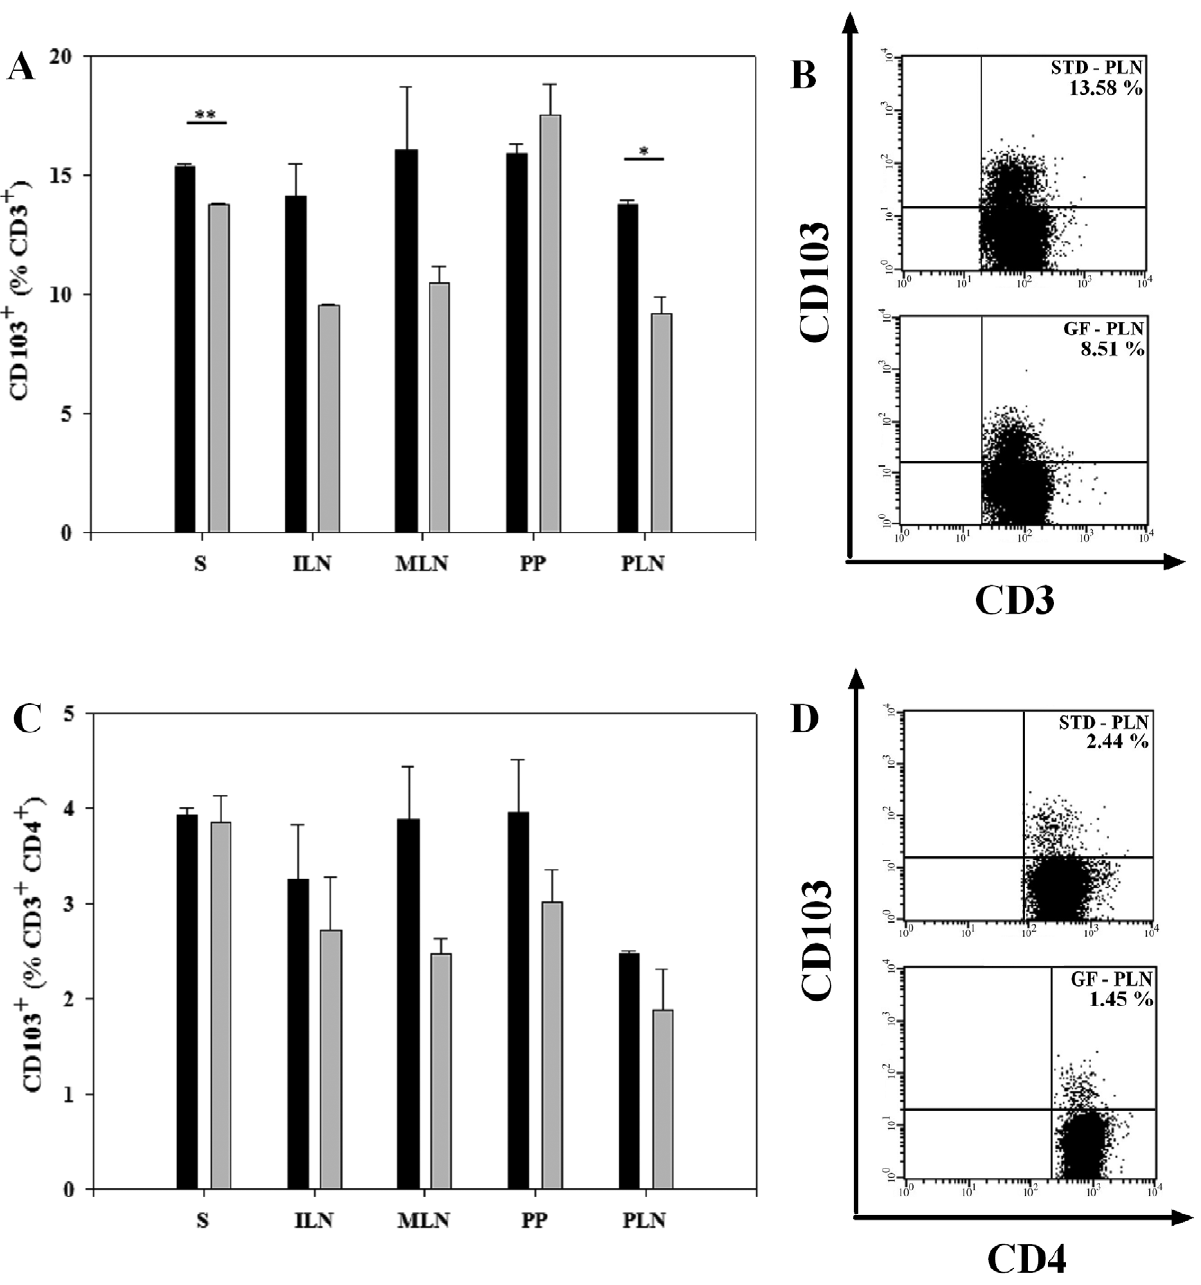
Figure 6. Increase in CD103 + T cells in S and PLN in mice receiving the STD diet. ( A ) Bars represent the proportion of CD103 + cells, gated on 100% CD3 + cells. There was an increased proportion of CD103 expression in S and PLN in BALB/c mice receiving the STD diet. ( B ) Representative dot plot from PLN showing the differences in CD103 + T cells between the two diets. ( C ) Bars showing the percentages of CD103 + cells gated on 100% CD3 + CD4 + lymphocytes. ( D ) Representative dot plots of CD4 + CD103 + T cells from isolated PLN. Barplots are mean values 6 SEM of two independent experiments with 6 mice in each group. Spleen (S); inguinal lymph nodes (ILN); mesenteric lymph nodes (MLN); Peyer’s patches (PP) and pancreatic lymph nodes (PLN). Black bars: STD diet. Grey bars: GF diet. * P , 0.05. ** P , 0.01. doi:10.1371/journal.pone.0033315.g006 the CD3 + and the CD3 2 cells. No statistically significant difference in proportions of CD3 + CD49b + or CD3 2 CD49b + cells were found in neither S, ILN, MLN, PP, PLN of BALB/c mice fed the STD versus GF diets (Fig. 7A/B). Although not significant a tendency towards a lower level of CD3 + CD49b + (NKT cells) were found in mice fed the STD versus the GF diet (Fig. 7A).